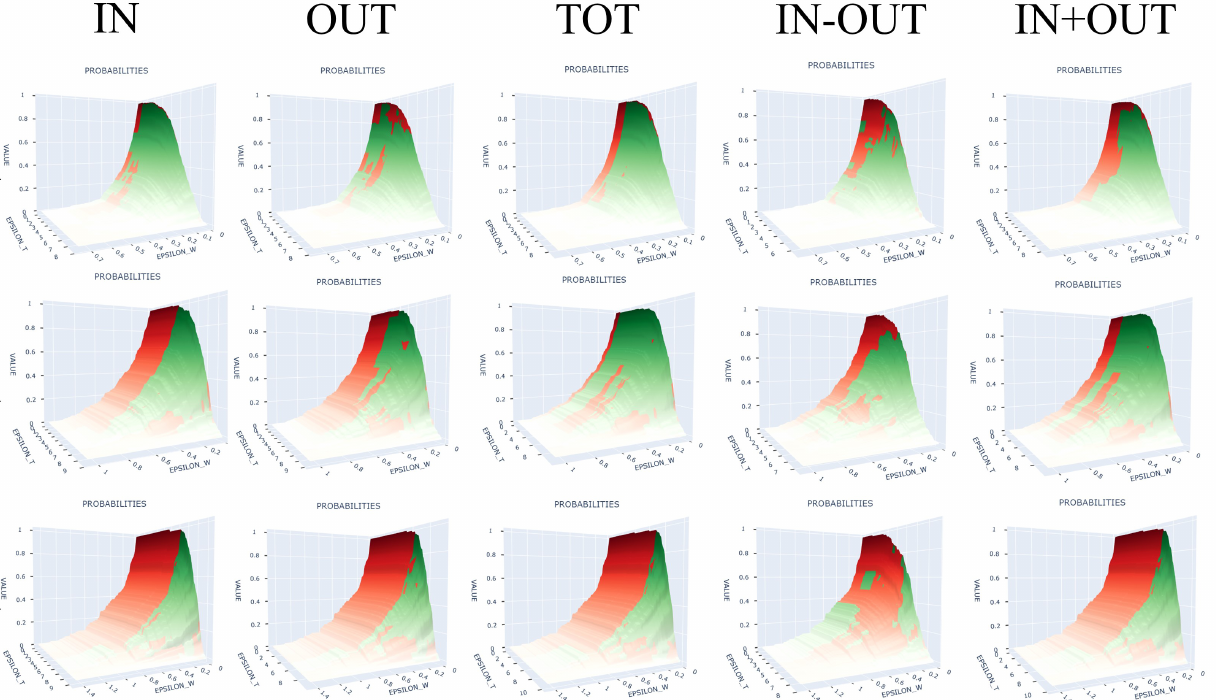
and 0 < (cid:101) T < (cid:101) ∗ ; IN, OUT, and TOT are T W